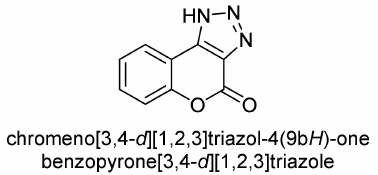
Figure 5. The common isomer of the fused chromeno-triazole system.